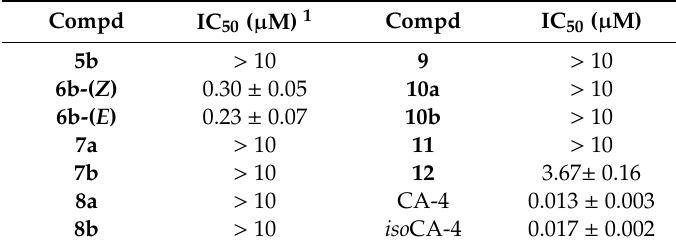
Table 1. Cytotoxic activities (IC 50 ) of compounds against HepG2 cells.